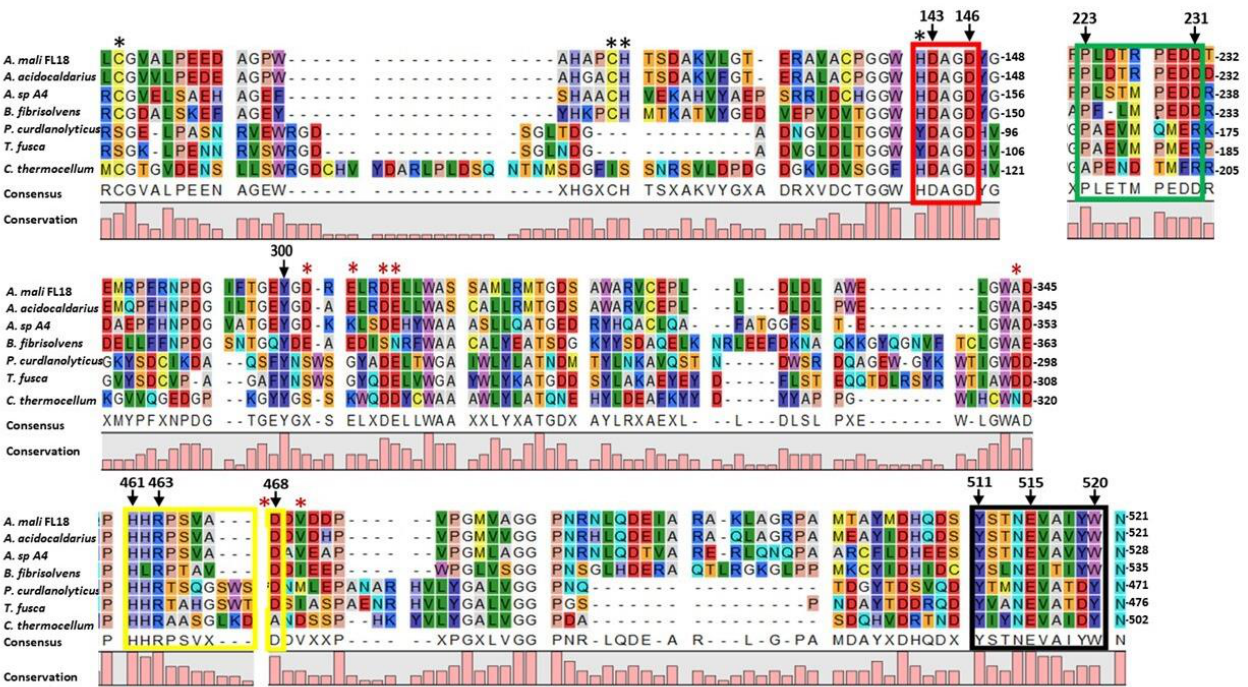
Figure 2. Multiple sequence alignment of AmCel9 aminoacidic sequence (from aa 103 to 521) with other GH9 family members realized with CLC Main Workbench 22.0.2. Red and black boxes highlight conserved catalytic residues; the yellow and green boxes indicate the regions involved in the interaction with Ig-like domain and substrate; the black and red asterisks mark the aa that interact with zinc and calcium ions, respectively. The highly conserved amino acid residues are indicated by arrows.